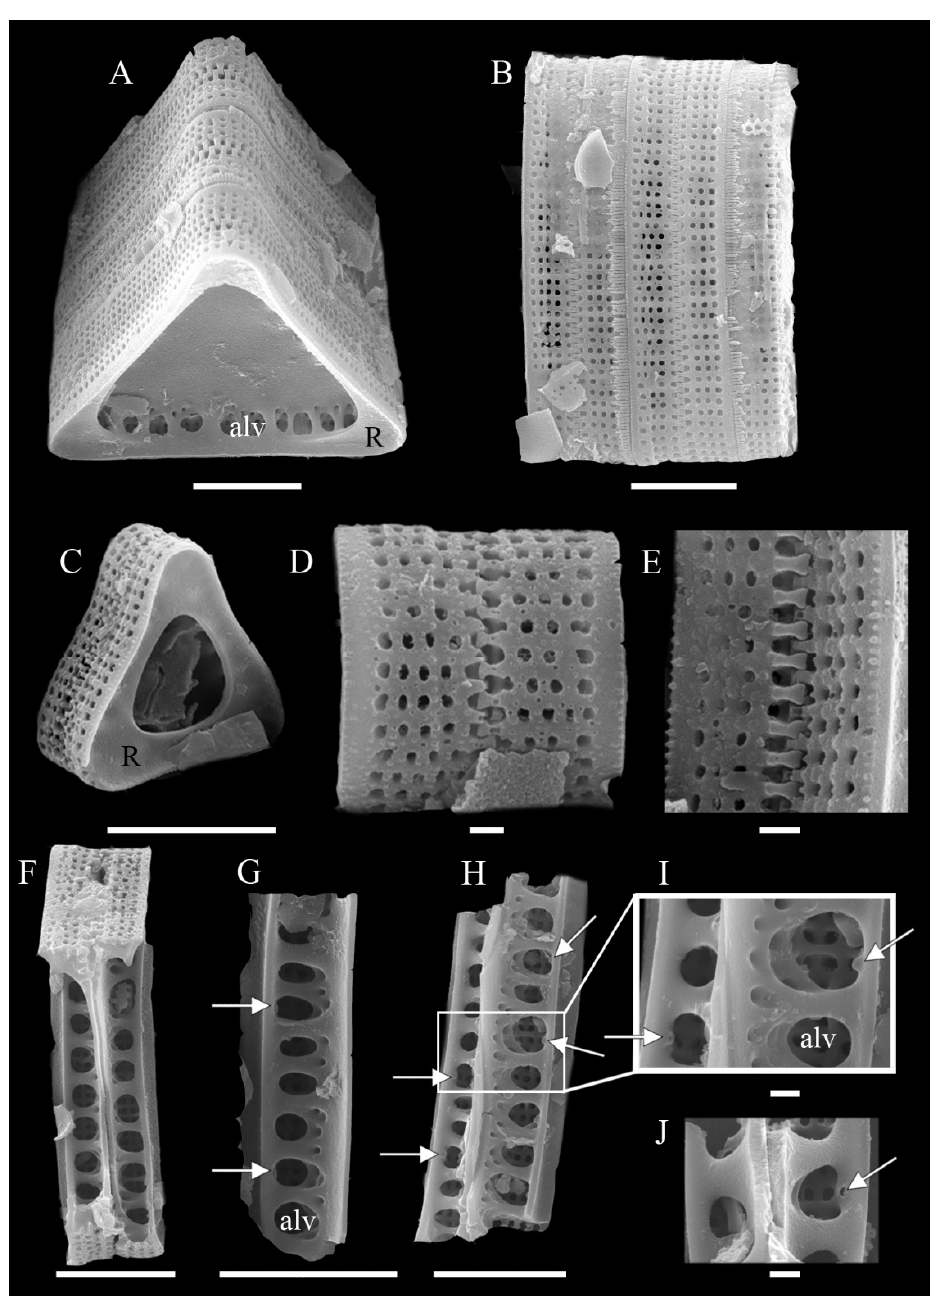
Figure 12. Alveolophora antiqua in the depth range of 48 to 44.5 m from core 517 of the Barguzin Valley: ( A – D )—external views, showing variability of valves; ( E )—linking spines; ( F – J )—internal views, showing, alveolae and rimoportulae (arrows). SEM. Scale bar: 10 µm ( A – E , I ) and 1 µm ( F – H , J ). A detailed study of A. antiqua morphological variability from different core horizons allowed us to establish an extended diagnosis for this species.